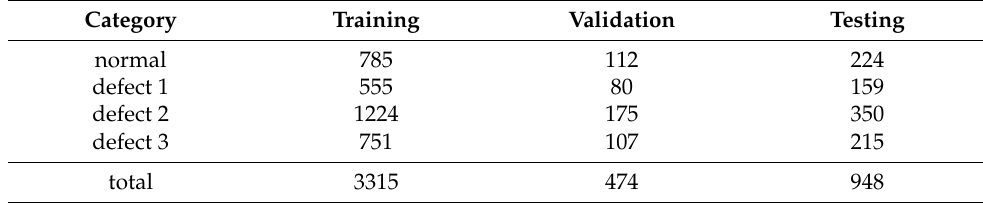
Table 3. Details of each dataset.